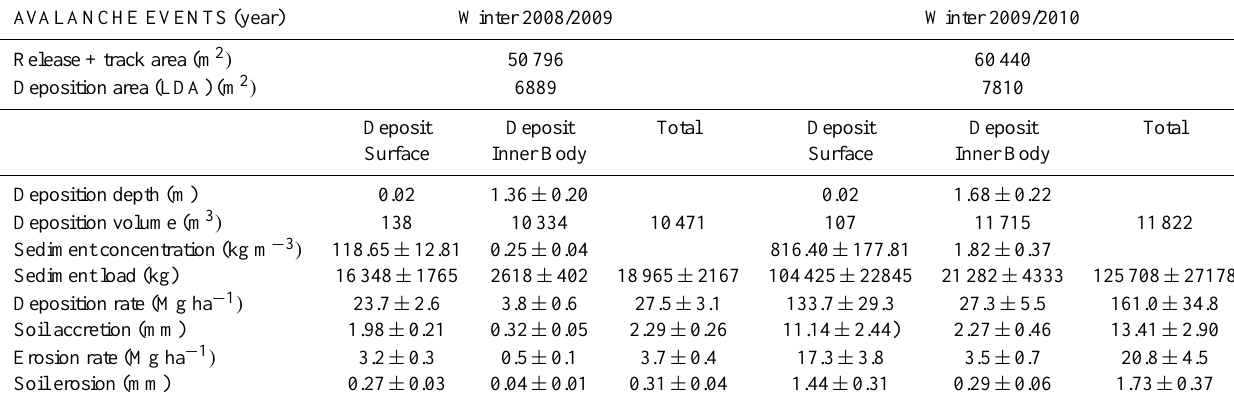
Table 1. Main characteristics of the two snow avalanches (2009 and 2010) with the mean concentration values ( ± SE) of the sediment transported into the Lower Deposition Area (LDA) and with the relative soil accumulation and erosion